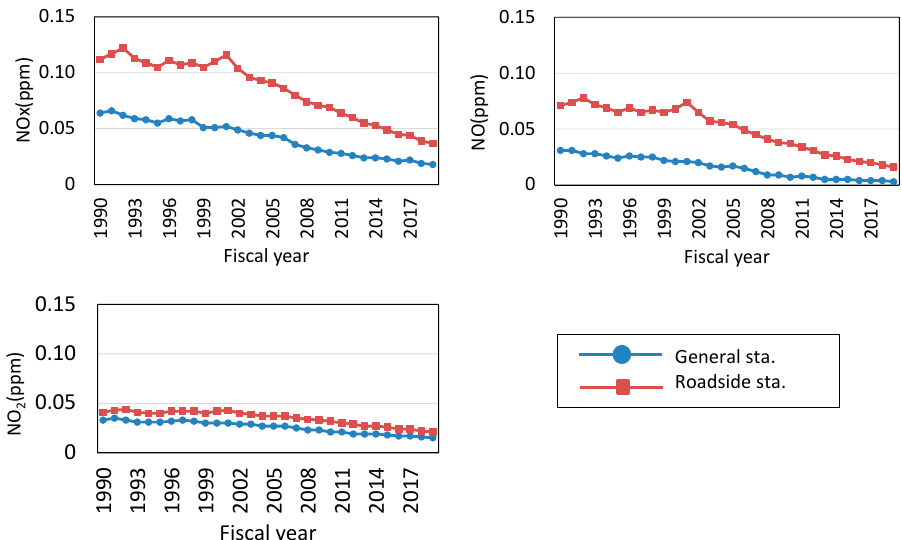
Figure 17. Trends in the annual averages of NOx, NO, and NO 2 . NOx, NO 2 , and NO: annual averages of hourly NOx, NO 2 , and NO at all nine General sta. and all nine Roadside